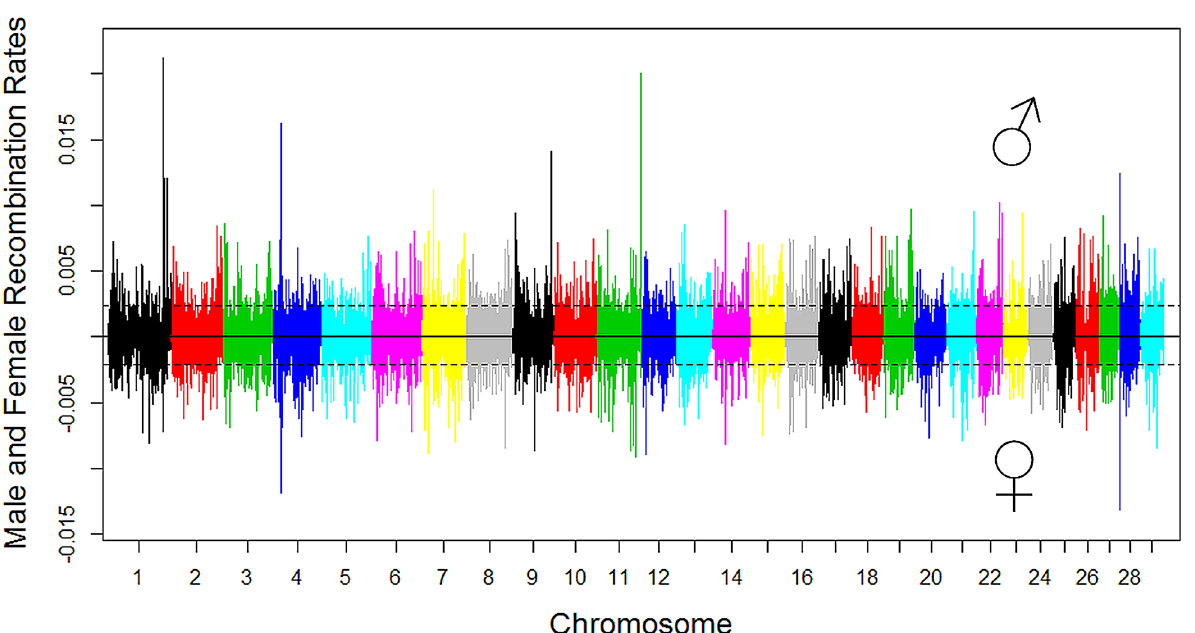
Fig 3. Genome-wide distribution of male and female recombination rates in SNP intervals of each chromosome. Male recombination rate was shown in the top half of the figure and female recombination rate was shown in the bottom by multiplying the original female recombination rate with ‒ 1. The dotted lines denote the threshold of 2.5 standard deviations plus the mean for recombination hotspot, 0.0023 for males and 0.0021 for females. Different colors were used to distinguish the 29 bovine autosomal chromosomes.